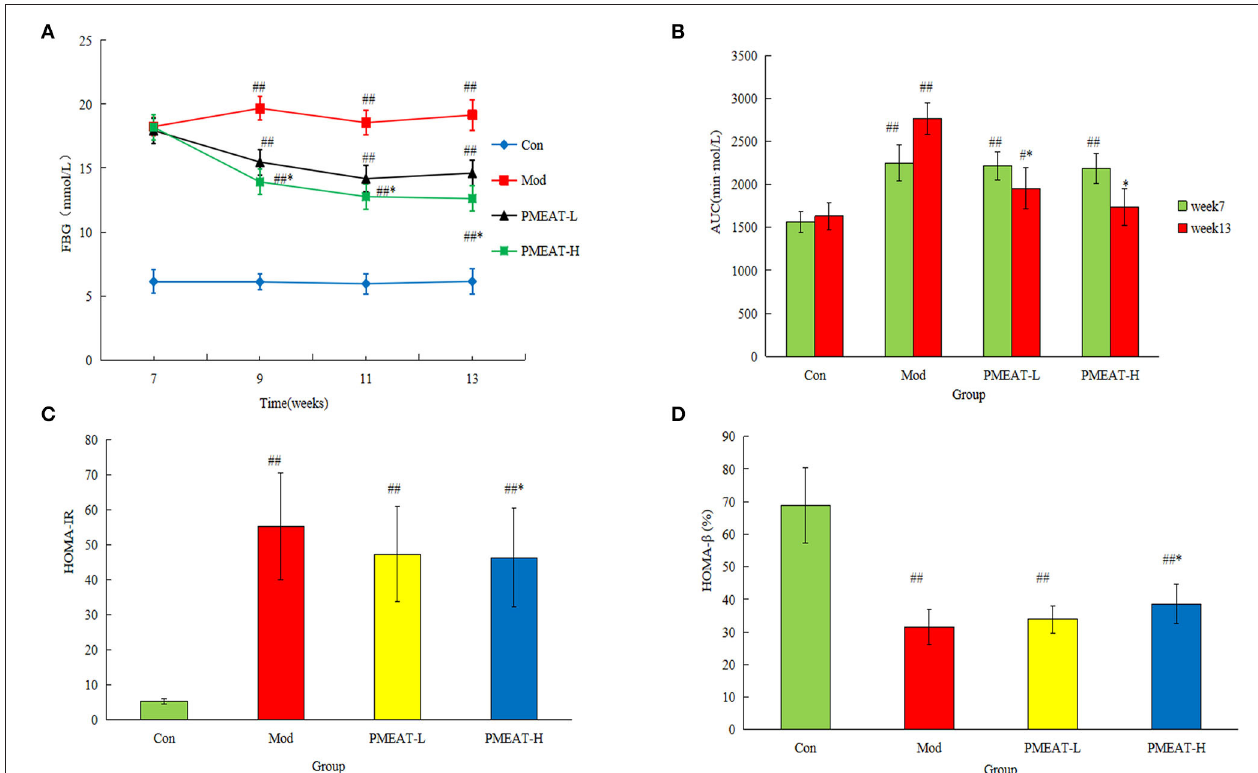
FIGURE 3 | The hypoglycemic effect of PMEAT on STZ-induced diabetic mice. (A) Fasting blood glucose of four observed groups at different time points. (B) AUC of four observed groups. (C) HOMA-IR of four observed groups. (D) HOMA- β of four observed groups. One-way ANOVA was applied to examine the differences among four groups. Superscript # and ## indicate statistically significant differences compared with the Con group ( p < 0.05) and ( p < 0.01), respectively. Superscript * indicate statistically significant differences compared with the Mod group ( p < 0.05). Con, control group; Mod, model group; PMEAT-L, low-dose PMEAT group; PMEAT-H, high-dose PMEAT